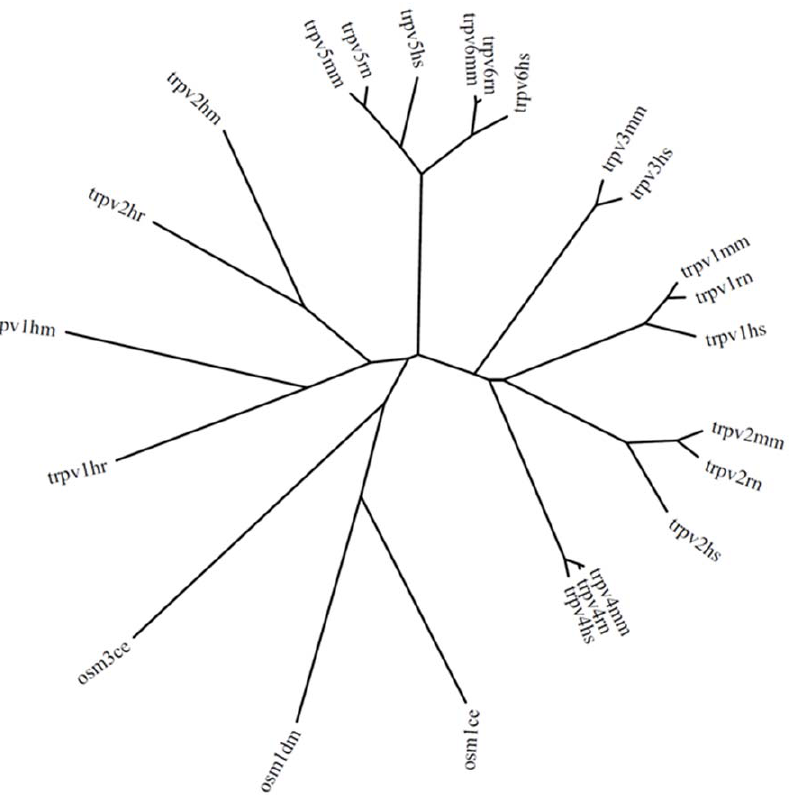
Figure 9. Phylogenetic tree showing Hirudo , Helobdella , mouse, rat, Human TRPVs and C.elegans , D.melanogaster OSMs. Leech TRPVs are slightly less diverged from mammalian TRPVs than those of C. elegans and drosophila and are closest to mammalian TRPV5 and TRPV6. (ce, Caenorhabditis elegans ; dm, Drosophila melanogaster ; hm, Hirudo medicinalis ; hr, Helobdella robusta ; hs, Homo sapiens ; mm, Mus musculus ; rn, Rattus norvegicus ).